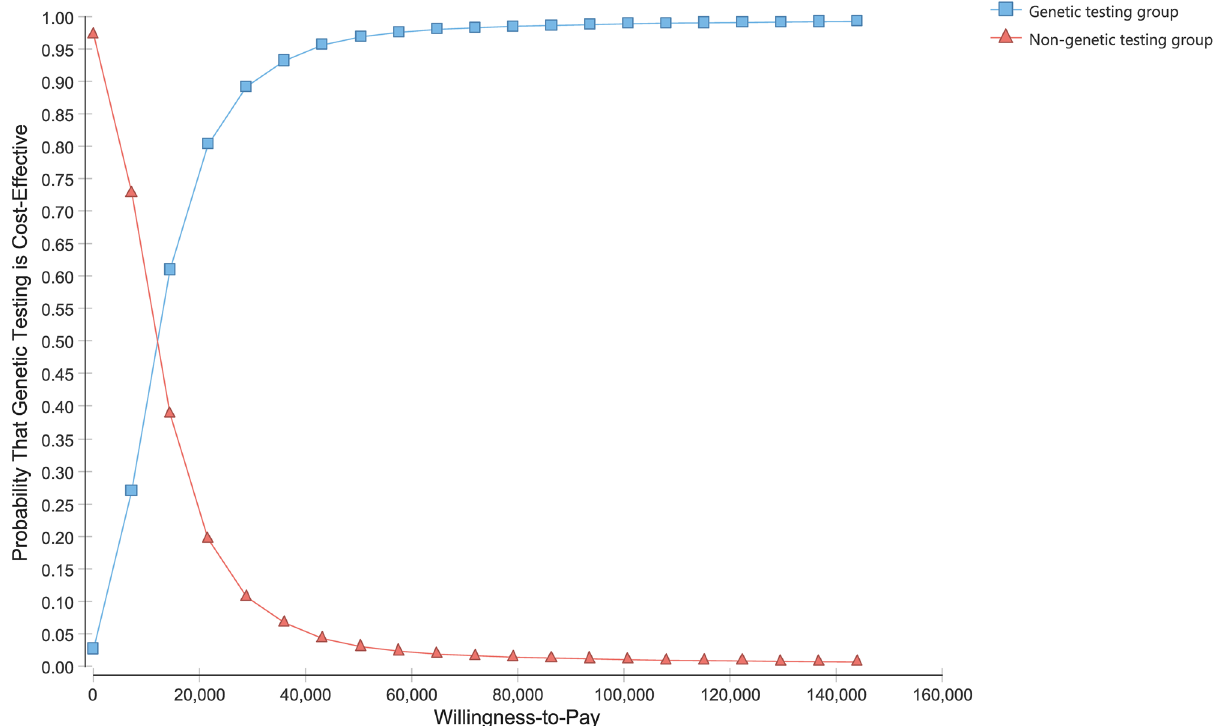
Figure 3. Cost-effectiveness acceptability curve and frontier; y-axis values indicate the probability of a strategy being cost-effective across a wide range of willingness-to-pay thresholds. The solid vertical line represents the willingness-to-pay threshold of CNY 216,000 per QALY. The dashed vertical line represents CNY 72,100 per QALY. CNY, Chinese Yuan Renminbi.